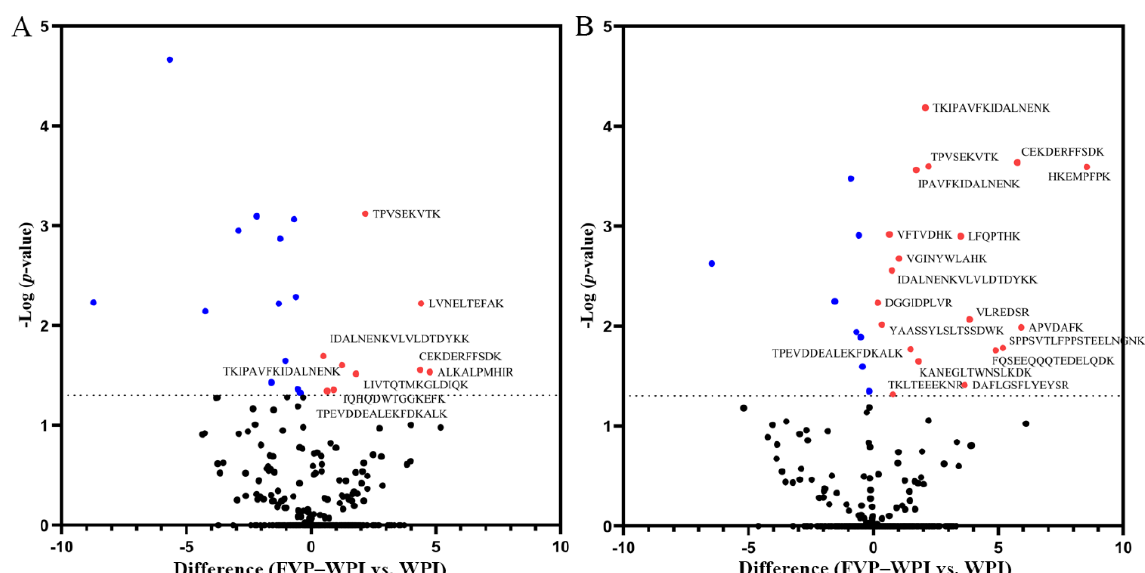
Figure 6. The volcano plots of the change in peptide abundance between FVP–WPI and WPI (control). ( A ) Differences of peptides digested for 10 min. ( B ) Differences of peptides digested for 120 min. Significant changes ( p -value < 0.05) appear in the upper left (significant decrease) and upper right quadrants (significant increase) of the plot. The color is used to distinguish whether the sequences are different. Red circles represent significant increase and blue circles represent significant decrease.